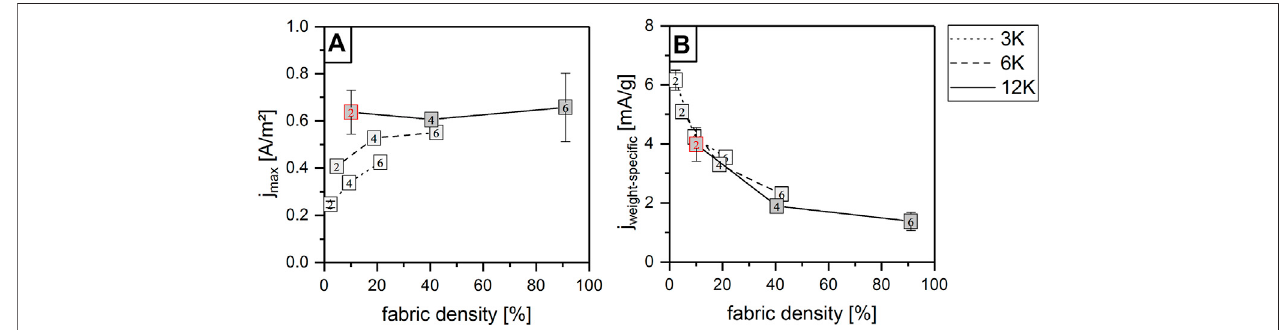
FIGURE 3 | Dependency of S. oneidensis maximum 2D current density (based on both sides of the fabric) j max (A) and electrode weight-speci fi c current density j weight-speci fi c (B) onthefabricdensityofplain-CM2fabrics.Thetwocomponentsthatmakeupthefabricdensity — towsizeandyarninput — areseparatelyhighlighted(line style: tow size; symbols: 2-4-6 yarns/cm). Key conditions were replicated with n ≥ 3 (datapoints with error bars), others are n = 1. All current densities are reported with respected to two sides of the planar electrode (2x projected surface